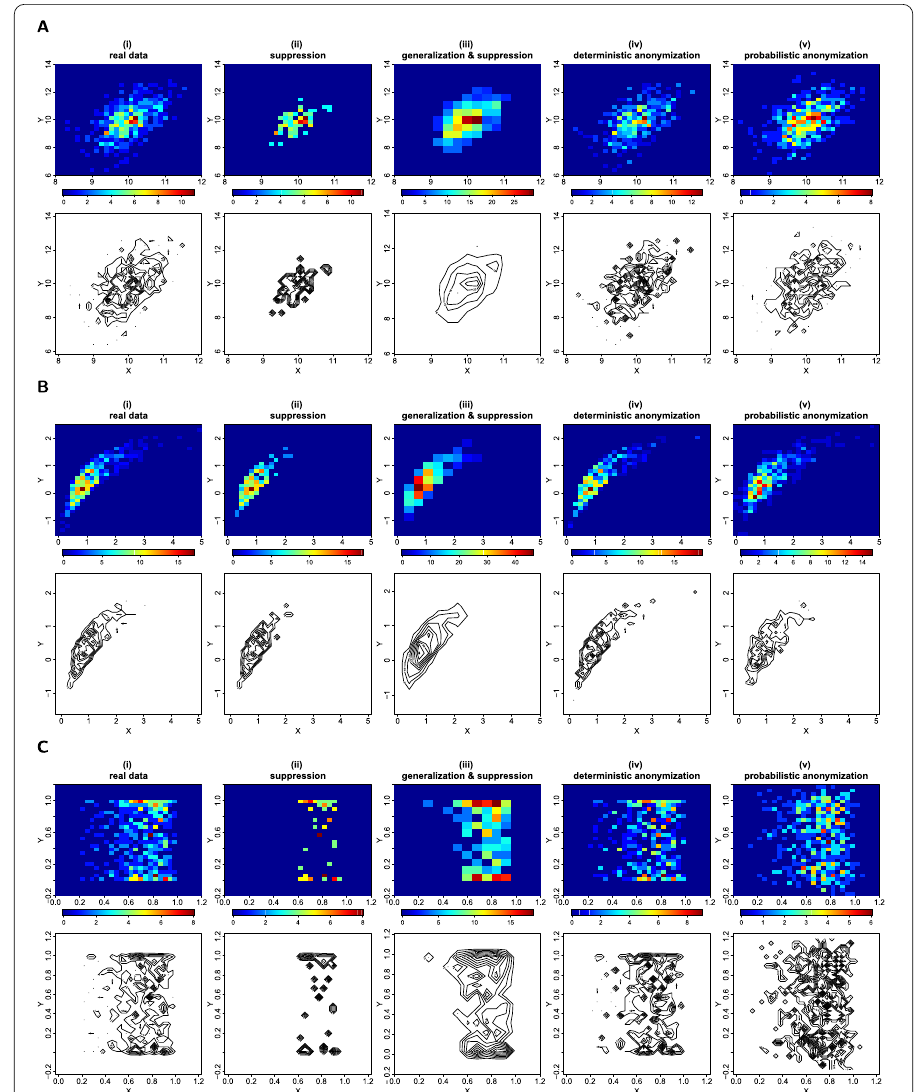
Figure 3 Privacy-preserving heat map and contour plots. Figures ( A ), ( B ) and ( C ) show the heat map (top rows) and contour (bottom rows) plots of X and Y from datasets D 1, D 2 and D 3 respectively. From left to right we demonstrate the plots produced by: (i) the actual 30 by 30 density grid matrix; (ii) the actual 30 by 30 density grid matrix but suppressing any grids with density less than three counts; (iii) a generalized to 15 by 15 density grid matrix and suppressing any grids with density less than three counts; (iv) a 30 by 30 density grid matrix of deterministically anonymized variables using the value of k = 3 when locating the k -nearest neighbours; (v) a 30 by 30 density grid matrix of probabilistically anonymized variables generated by adding random noise to the actual variables, of variance equal to 6.25% of their actual variance. Note that the colour scale differs between the different heat map plots